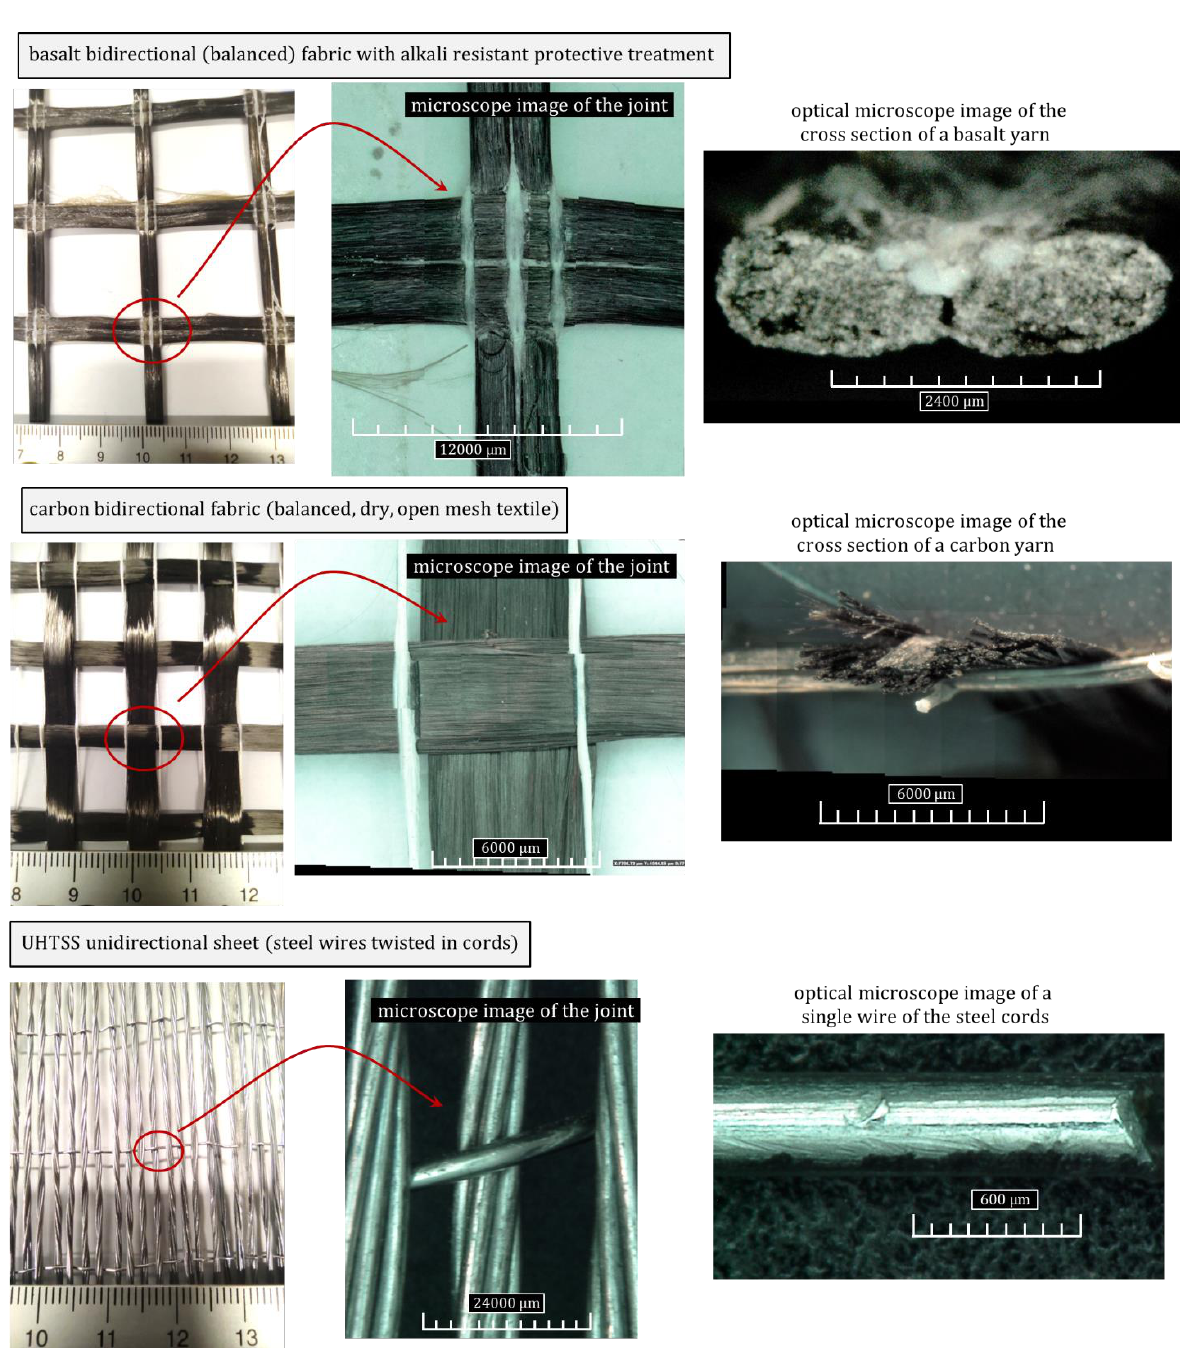
Figure 2. Fibers used for preparing FRCM coupons (numbers indicated in rulers on the left-side photos are units in [cm]). Table 2. Physical characteristics of the resins/binders used in the customized cementitious matrices.